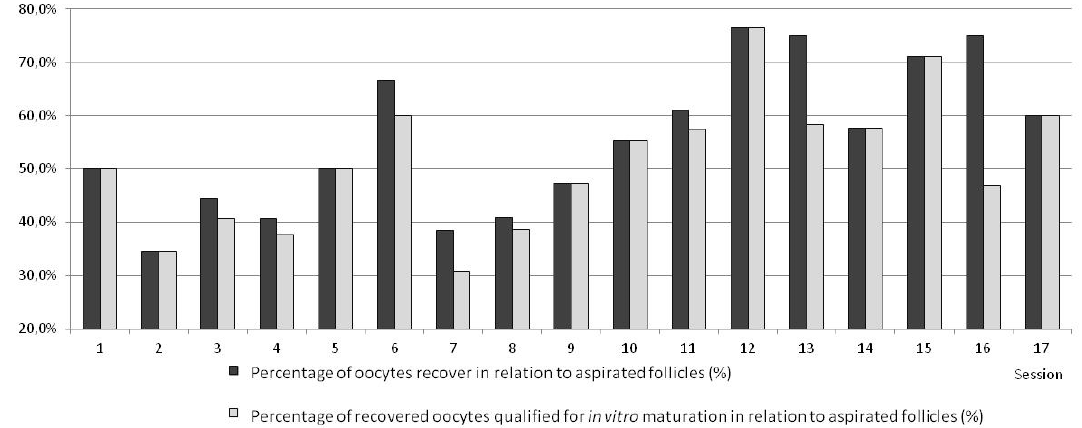
Figure 5. Comparing various L-OPU sessions with respect to percentages of recovered oocytes and oocytes selected for in vitro maturation (IVM) in sheep. (Variant I—sessions 1–3, Variant II—sessions 4–6, Variant III—sessions 7–13, Variant IV—sessions 14–17).